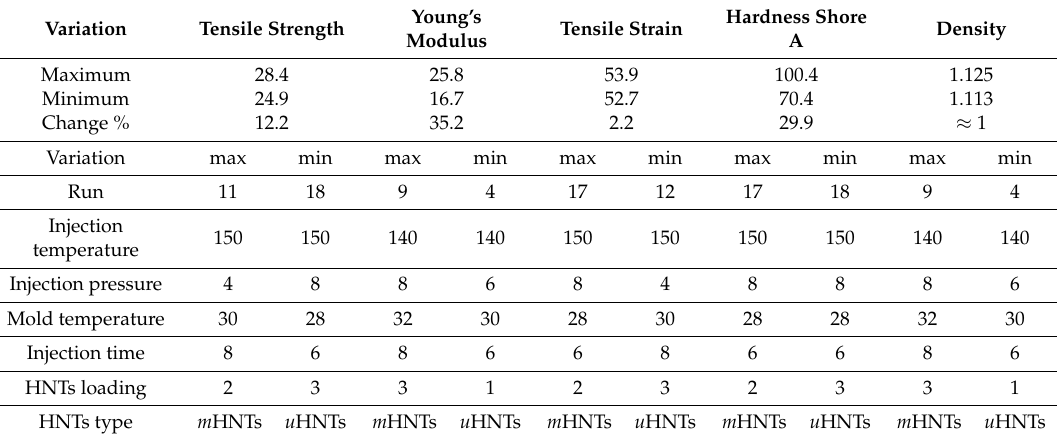
Table 4. The variation of the